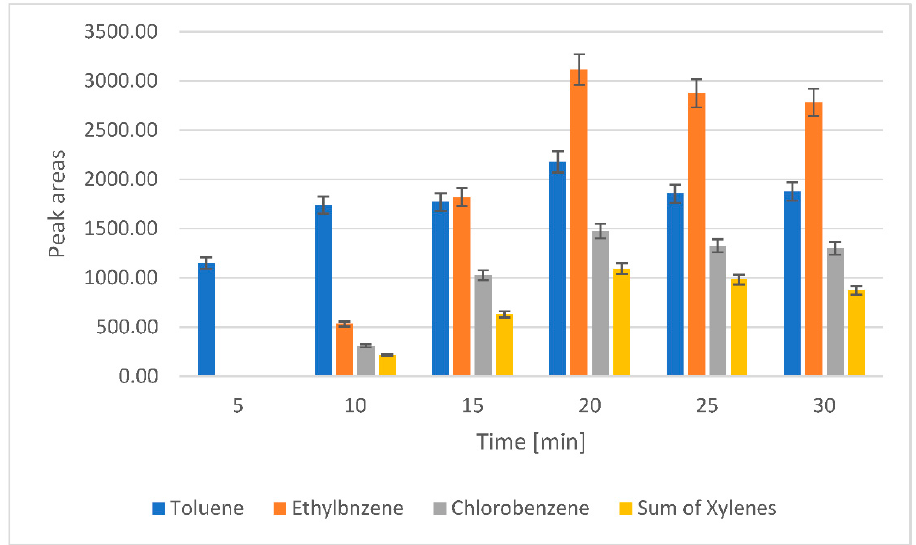
Figure 2. The effect of sampling time on the efficiency of toluene, ethylbenzene, chlorobenzene, and xylene transfer to the gas phase. The dependence of the peak areas on the sampling time.